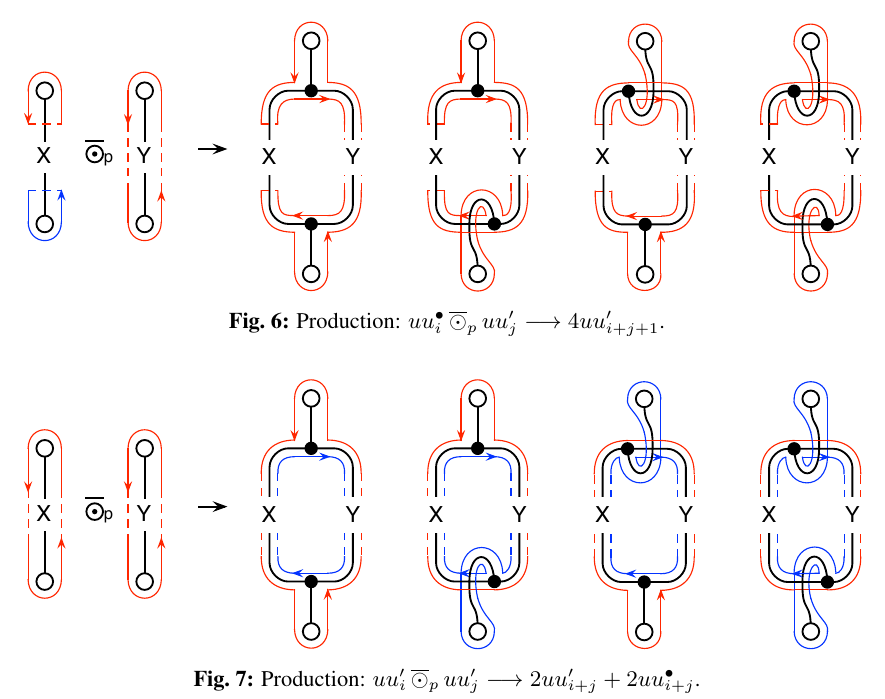
Fig. 6: Production: uu • i (cid:12) p uu (cid:48) j −→ 4 uu (cid:48) i + j +1 .